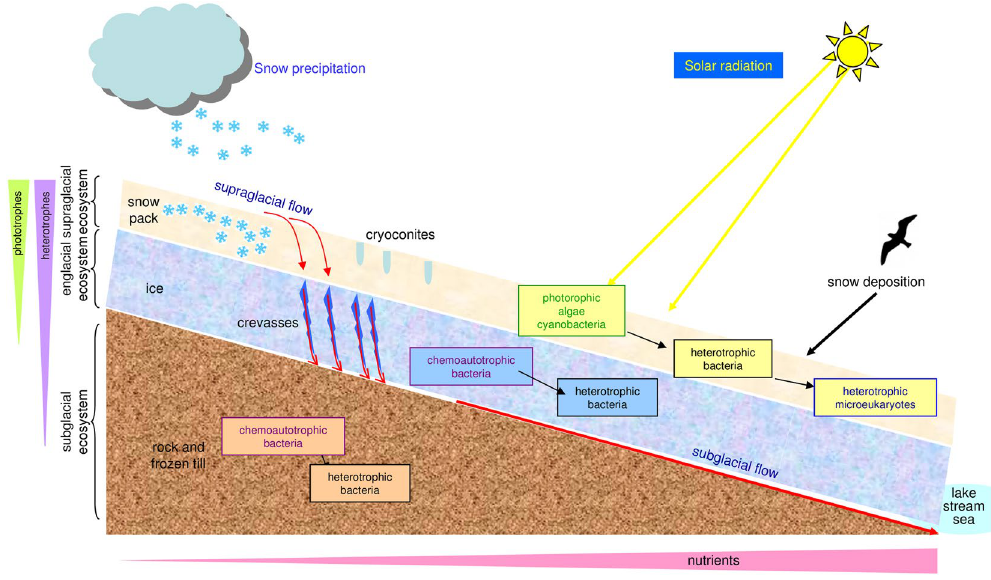
Figure 1. Ecosystems of a glacier colonized by microorganisms. The s upraglacial ecosystem is inhabited by photoautotrophic microorganisms, and by heterotrophic bacteria and microeukaryotes that feed on organic particles from atmospheric deposition. Microorganisms in the englacial ecosystem can be chemoautotrophs or heterotrophes that feed of solubilized products. Subglacial ecosystem contains a majority of chemolithotrophic microorganisms that are fed on the mineral salts of the rocks and basal soil and occupy ice/till